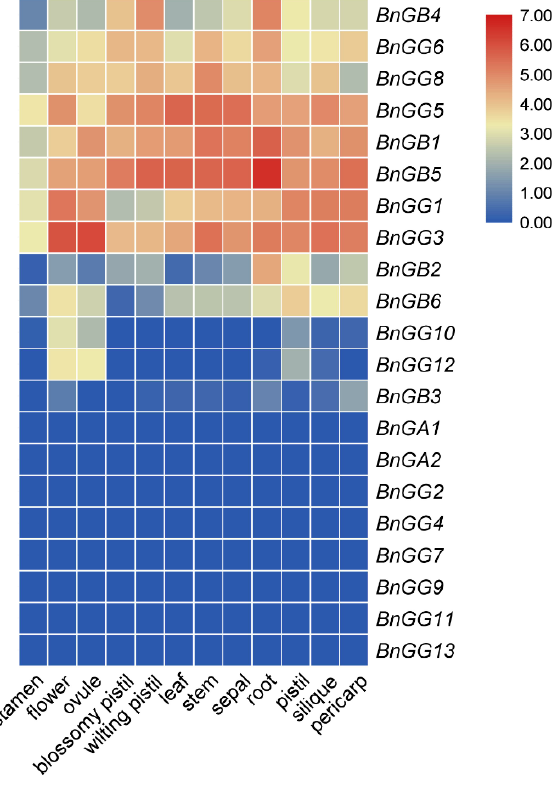
Figure 7. Expression profiles of G-proteins in different tissues and organs of B. napus . FPKM values of G-protein genes were transformed by log2 and the heatmap was constructed by TBtools.